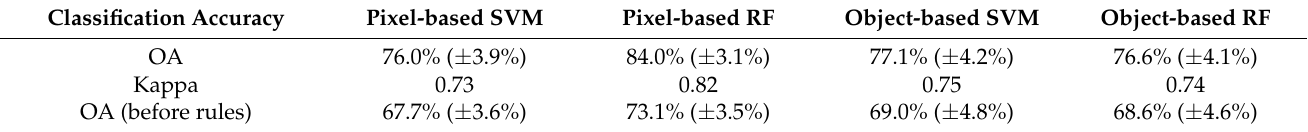
Table 8. Overall accuracies (OA) and Kappa statistics of the four classification methods, including pixel-based support vector machine (SVM), pixel-based random forest (RF), object-based SVM and object-based RF. The values inside the parentheses indicate the 95% confidence intervals of the OA.